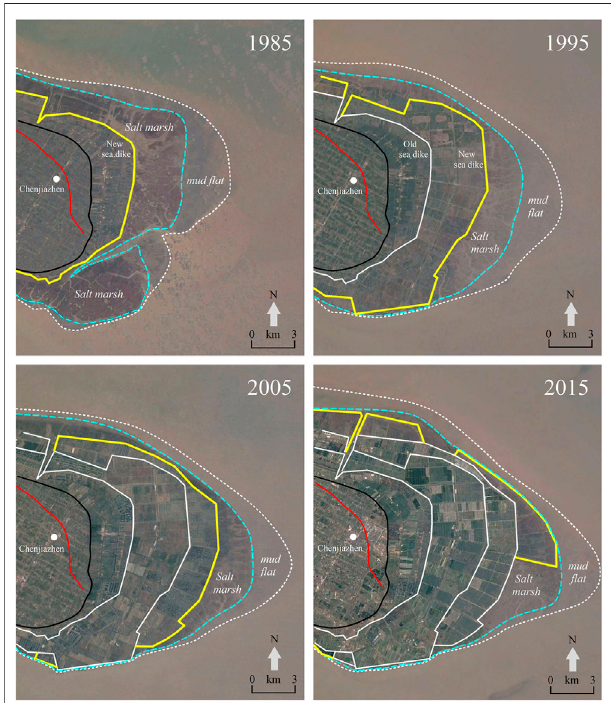
FIGURE7| Thesatelliteimagesofseadikesandtidal fl atsreclamationin easternChongmingIsland.Theredlinerepresentsthelocationofthesea-dike in 1762; the black line represents the shoreline in 1950; the white line represents old sea dikes; the yellow line represents new sea dikes in different periods; the broken blue line represents the boundary of salt marsh, and thebroken whitelinerepresentsthe boundaryofmud fl at.Dataon remote sensing image in four typical periods were excerpted from Google Earth; data on historical sea dikes and shoreline were excerpted from Yun (2010), Yang (2005), the Chronicles of Chongming County (Zhang and Zhu, 2013) and the Chronicles of Chongming County (Zhou, 1989).